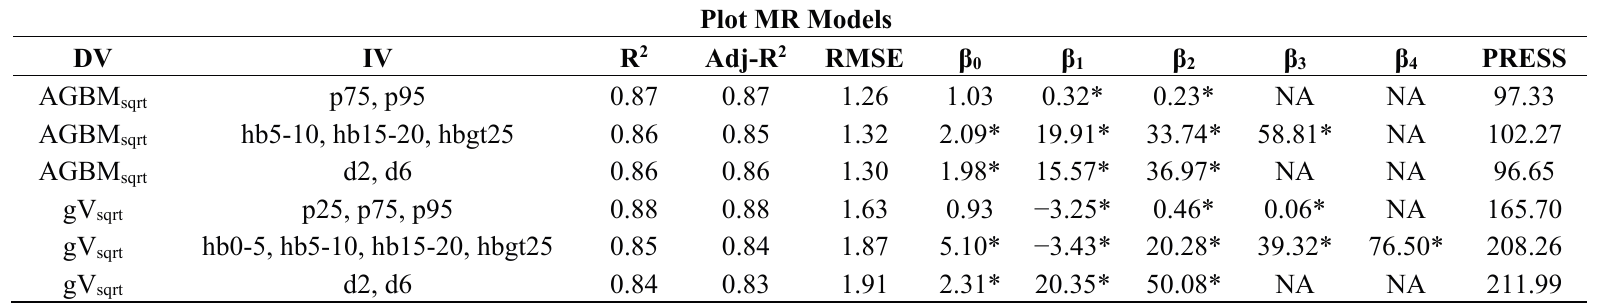
Table 11. Plot-level multiple regression analysis results. * indicates p -values of less than 0.05. Plot MR Models